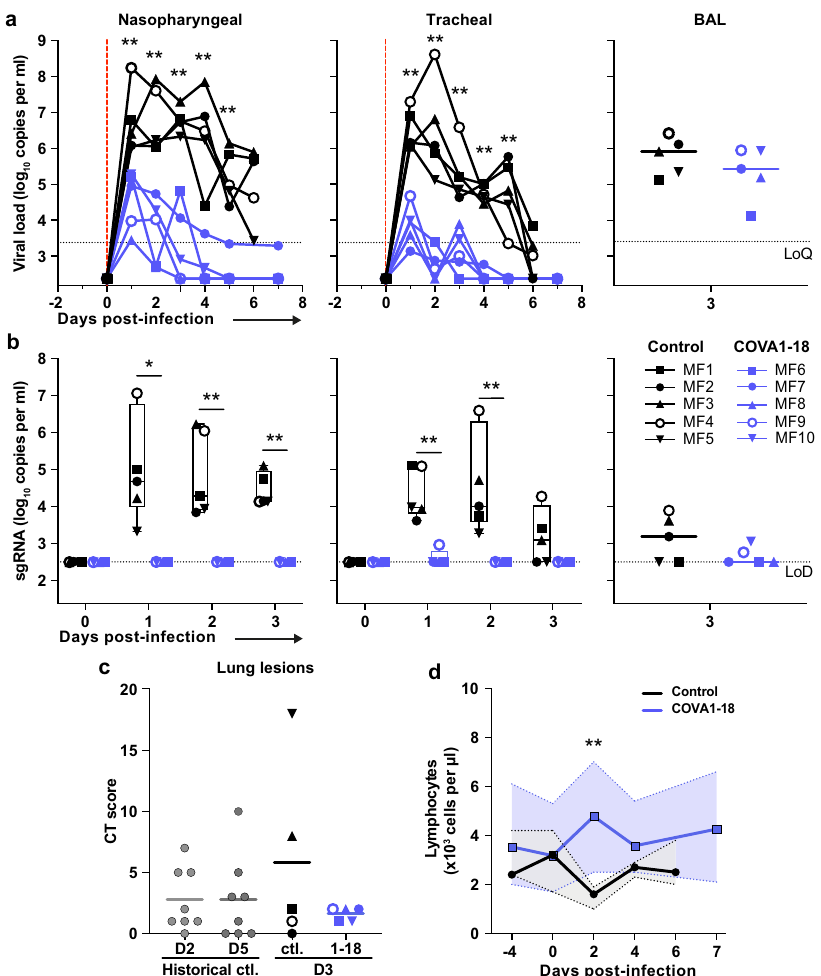
Fig. 3 COVA1-18 pre-exposure prophylaxis protects cynomolgus monkeys against SARS-CoV-2 challenge and clinical symptoms. a Genomic (g)RNA and b subgenomic (sg)RNA loads determined by PCR in nasopharyngeal fl uids (left), tracheal fl uids (middle) and bronchoalveolar lavages (BAL) (right). Individual values are plotted for nasopharyngeal and tracheal samples and bars represent medians for BAL. For b , boxes and whiskers representation with min-max., median, 25th – 75th percentile for n = 5 per group. c Chest CT scores were determined at 3 d.p.i. and at 2 or 5 d.p.i for historical controls ( n = 8). d Absolute lymphocyte count in the blood (mean with range). Mann-Whitney unpaired two-tailed t-test, p values: * < 0.05, ** < 0.01. 1 – 18, COVA1-18; CT Computed Tomography, Ctl. control group, LoD limit of detection, LoQ limit of quanti fi